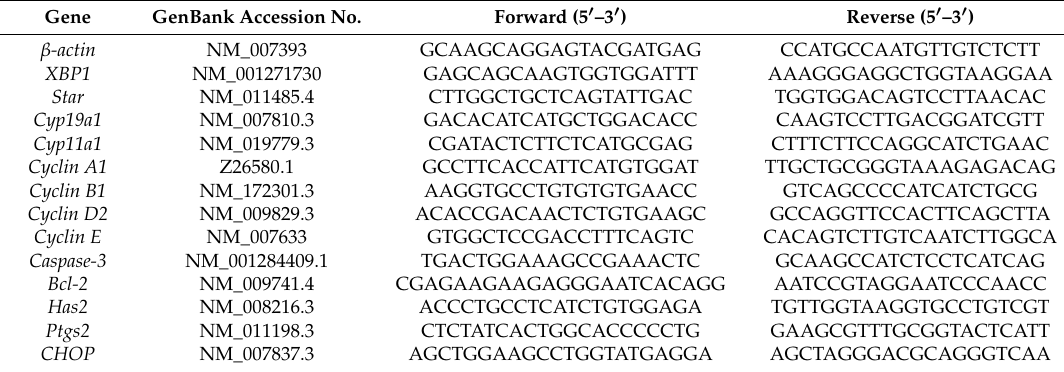
Table 4. Primer sequences used for quantitative real-time PCR